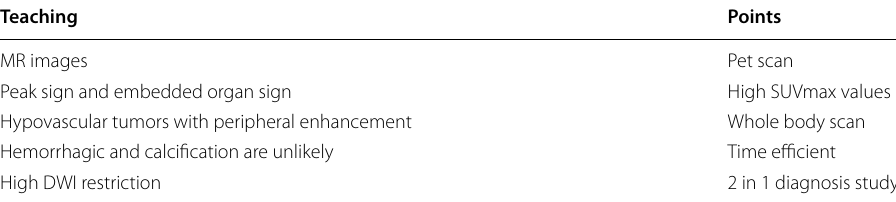
Table 2 Summary of teaching